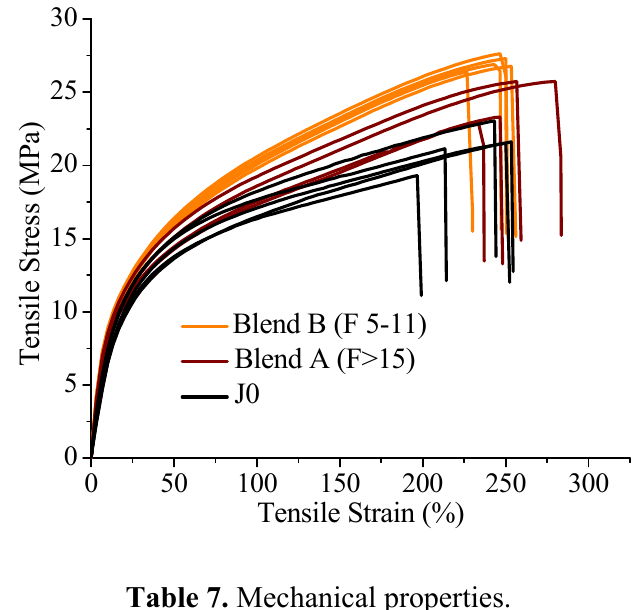
Figure 13. Mechanical properties of the blends.